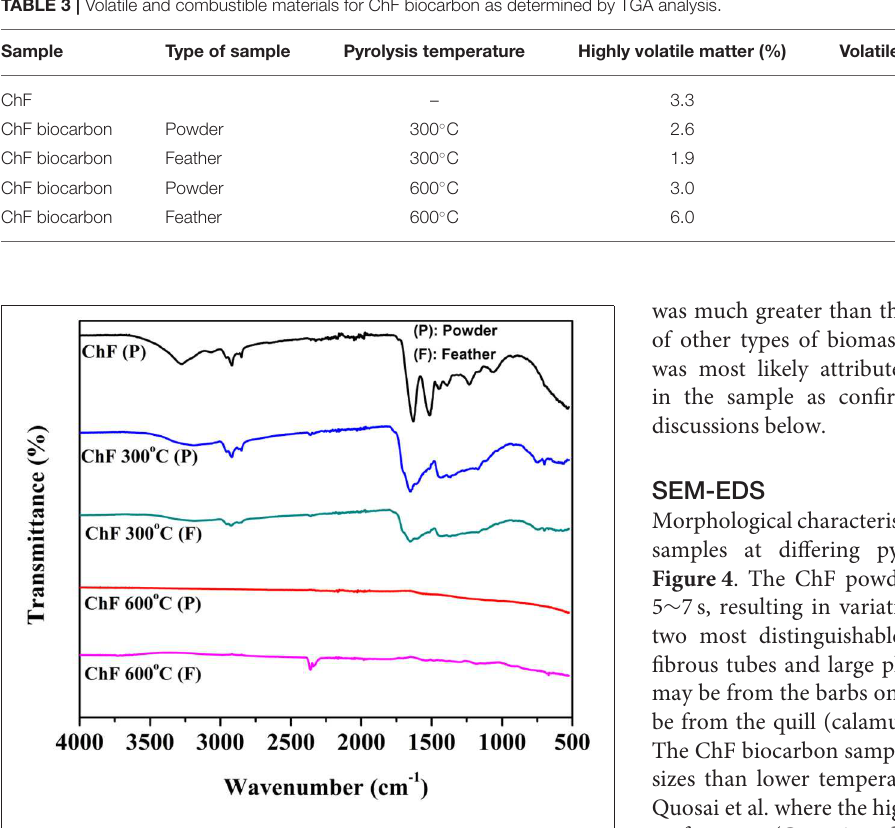
FIGURE 2 | FTIR spectra of ChF powder and ChF